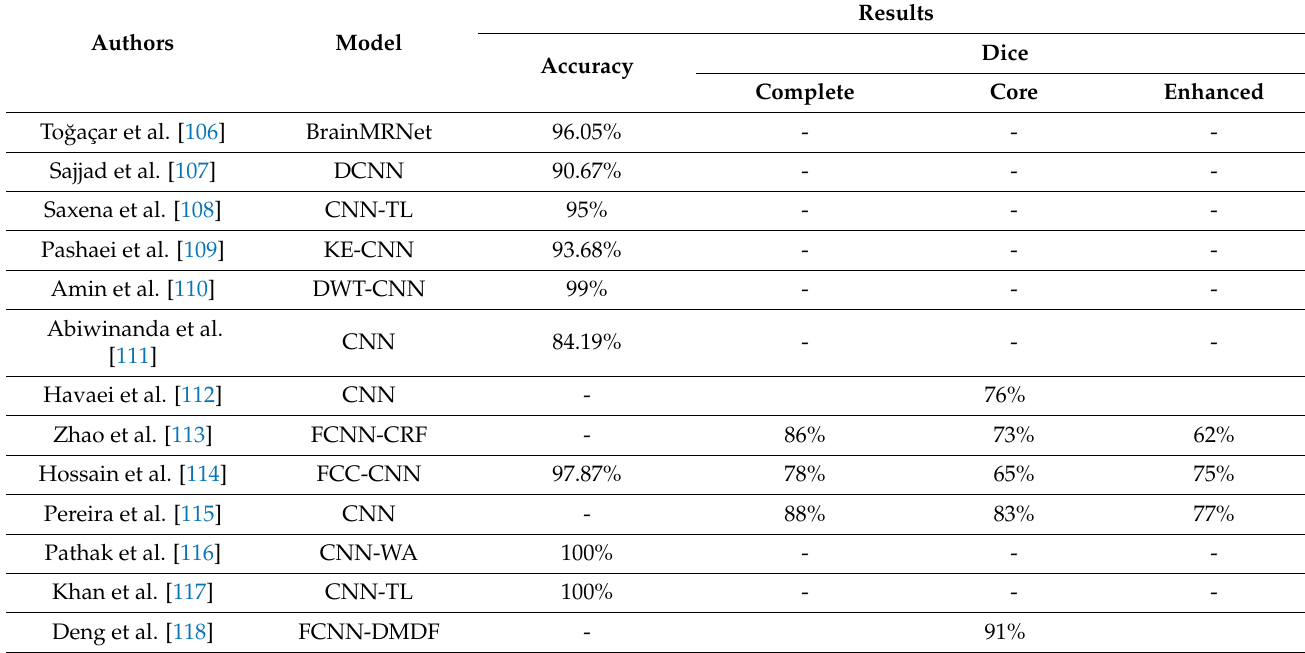
Table 5. Results of the application of convolutional neural networks in the brain tumor